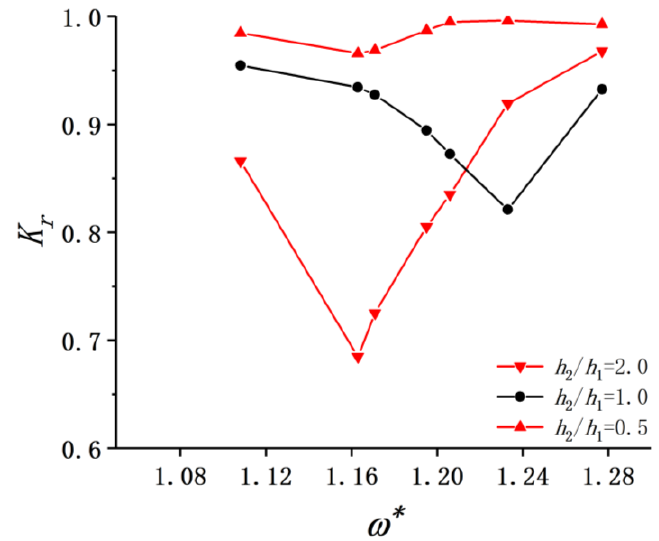
Figure 10. Transmission and reflection wave coefficient profiles against the incident wave frequency for different draft ratios. Top : transmission wave coefficient, bottom : reflection wave coefficient.